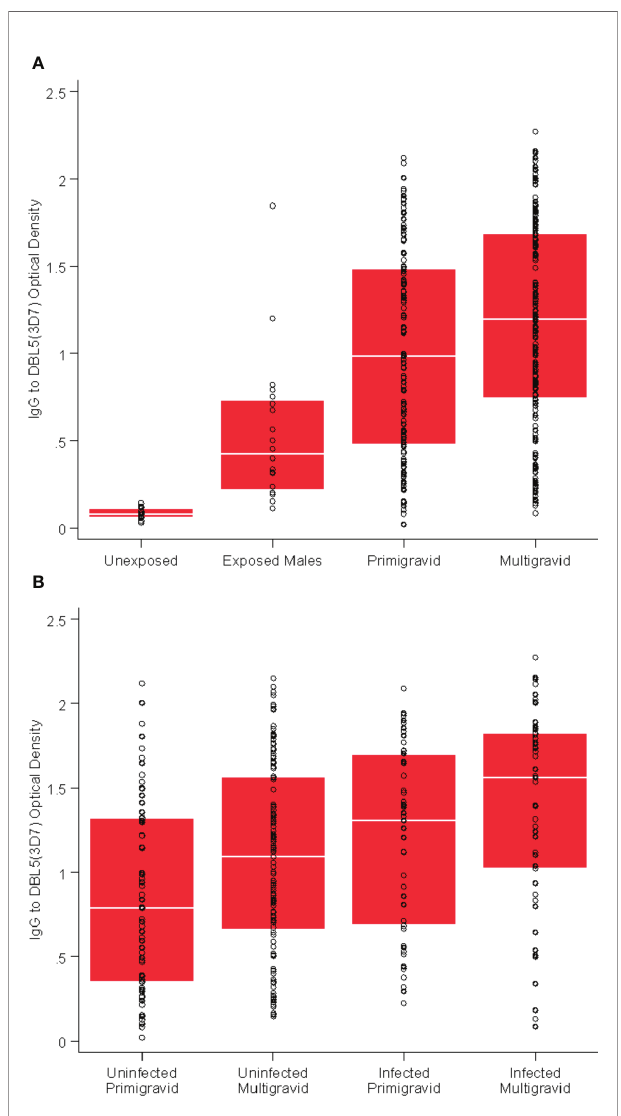
FIGURE 1 | VAR2CSA-speci fi c antibodies are associated with gravidity and exposure. (A) Total IgG to DBL5 (3D7) in unexposed Melbourne controls (n = 30); exposed males from Papua New Guinea (n = 20); primigravid women (n = 115); and multigravid (n = 186) women. p = 0.03 for multigravid versus primigravid; p < 0.01 for all other comparisons. (B) Total IgG to DBL5 (3D7) in primigravid uninfected at enrolment (n = 66); primigravid infected at enrolment (n = 49); multigravid uninfected at enrolment (n = 132); and multigravid infected at enrolment (n = 54). p = 0.02 and p = 0.08 for multigravid versus primigravid (uninfected and infected respectively); p < 0.01 for infected versus uninfected (primigravid and multigravid